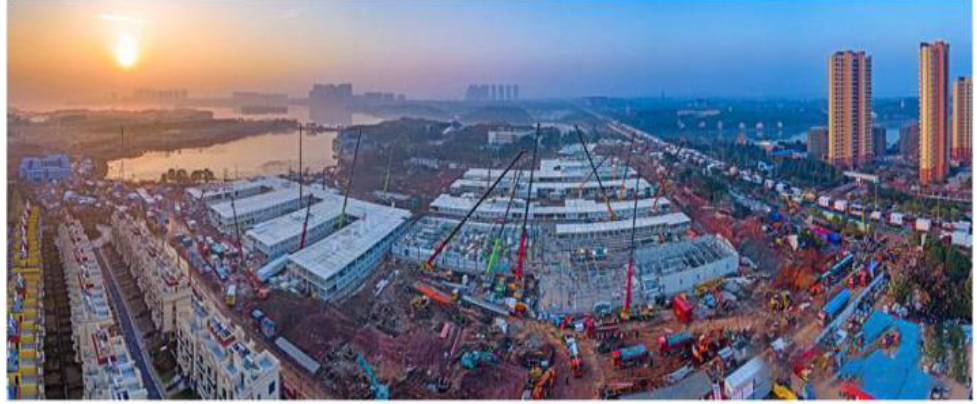
Figure 1. Wuhan Leishenshan Hospital [20].